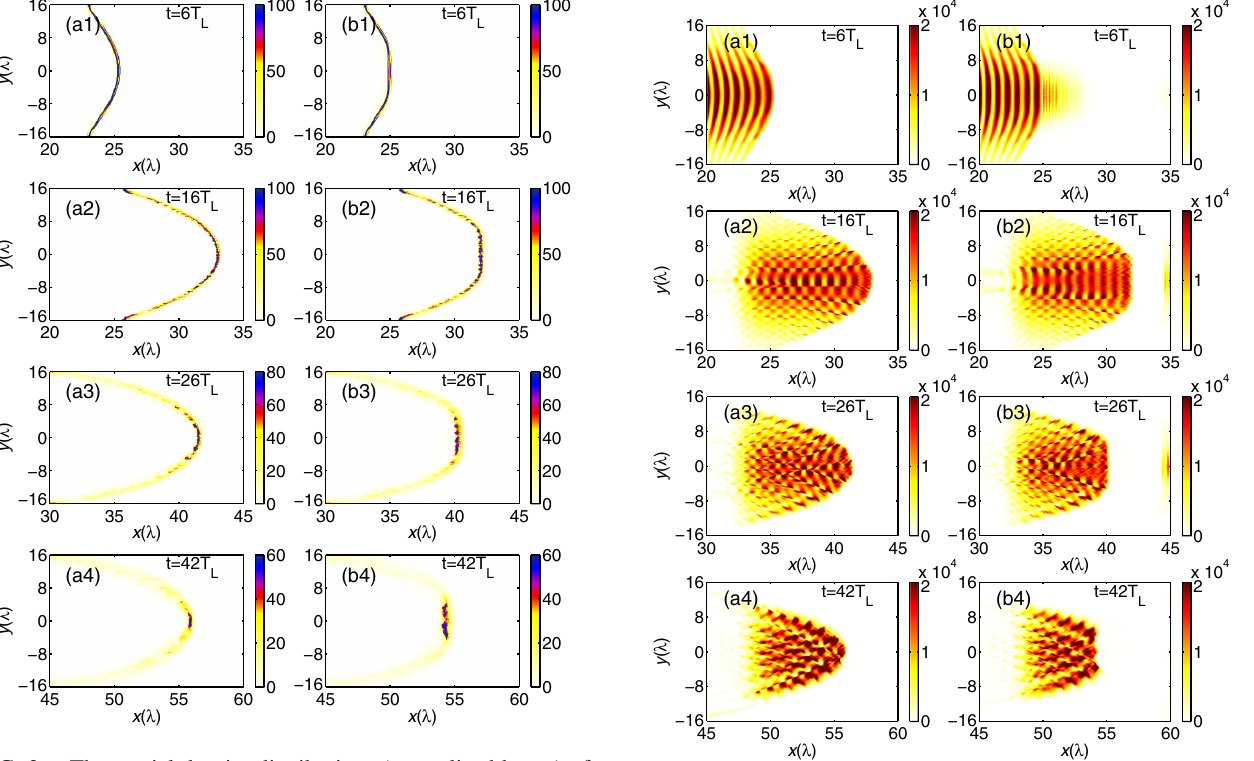
FIG. 4. The dimensionless spatial laser intensity distributions for the single laser case (a1) – (a4) and two lasers case (b1) – (b4). These snapshots are corresponding to four specific moments,